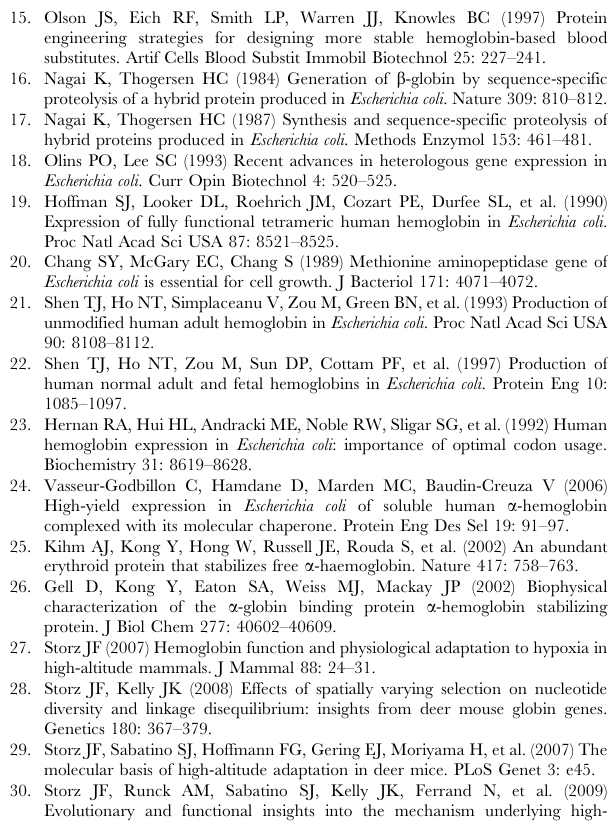
standard; (b) Densitometric analysis of rHbs in the soluble and